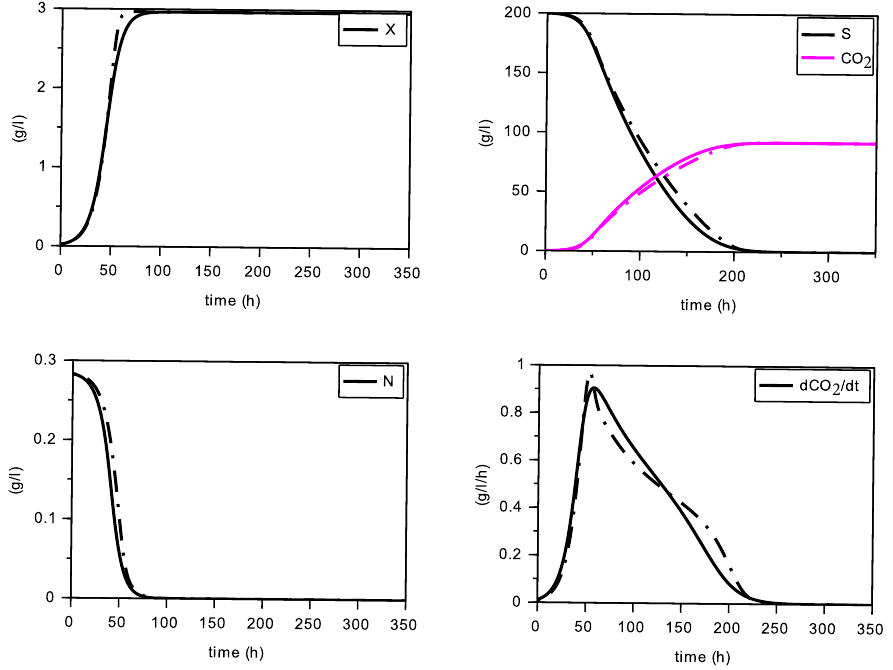
Figure 5. Comparison with the model with transporters (in dashed) for N ( 0 ) = 0.283 g · L − 1 (constant temperature of 24 ◦